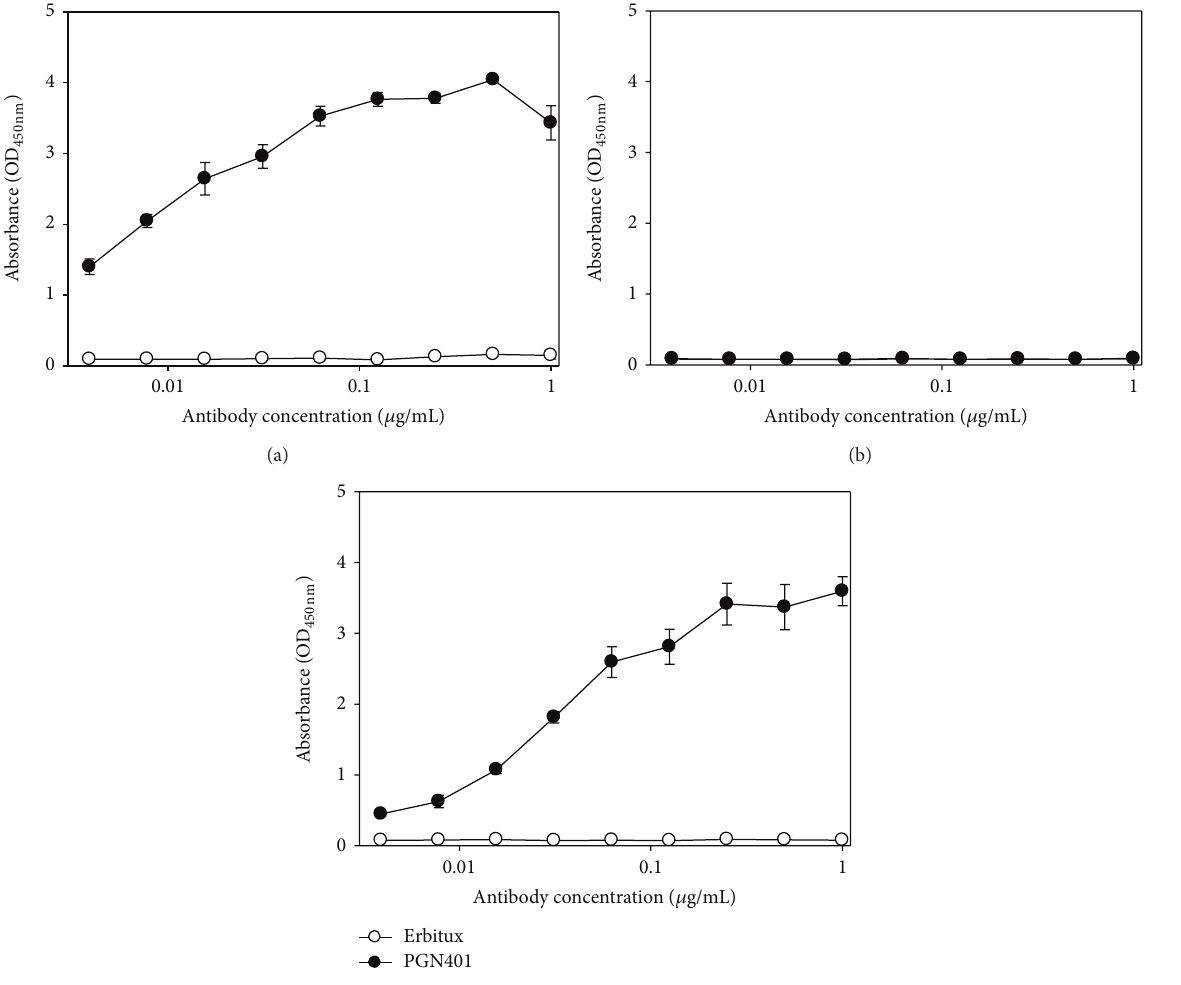
Figure 3: Binding of Erbitux and PGN401 antibodies to plates coated with (a) EBOV, (b) PBS, or (c) PS antigen using a twofold dilution series starting at 1 𝜇 g/mL. Binding levels were assessed by measurement of absorbance at a wavelength of 450 nm. Data points show mean values from three replicate wells with error bars denoting standard